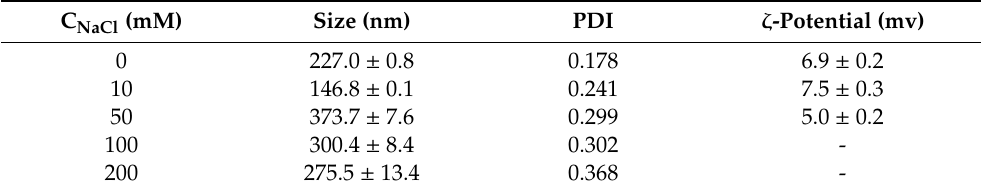
Sizes and ζ -Potentials of carboxymethyl inulin (CMI) / bovine serum albumin (BSA) nanocomplexes under di ff erent concentrations of NaCl at pH =